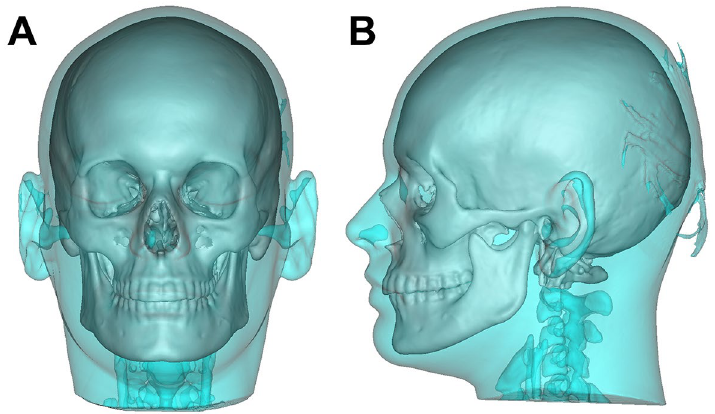
Figure 1. Segmented models of the facial soft tissue and the cranial and facial skeleton including the maxilla and the mandible.